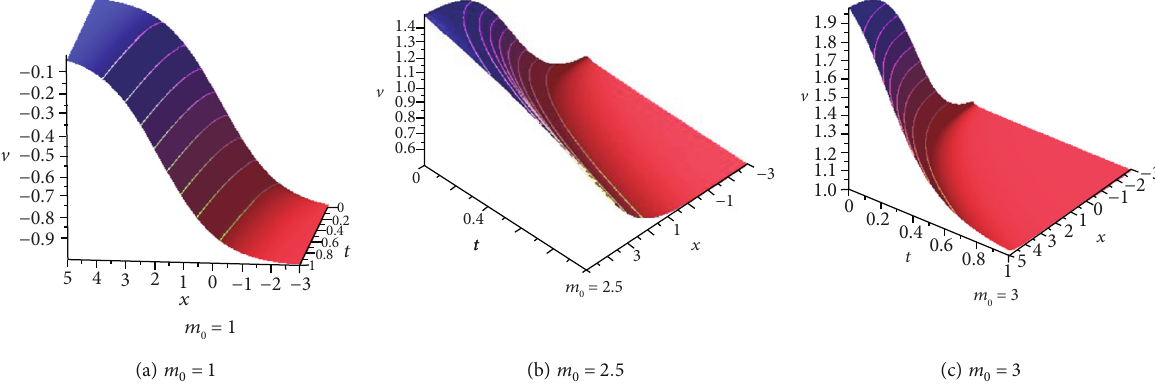
Figure 10: Kink wave for A = a = m straight surface for complete order and deform into a single peakon